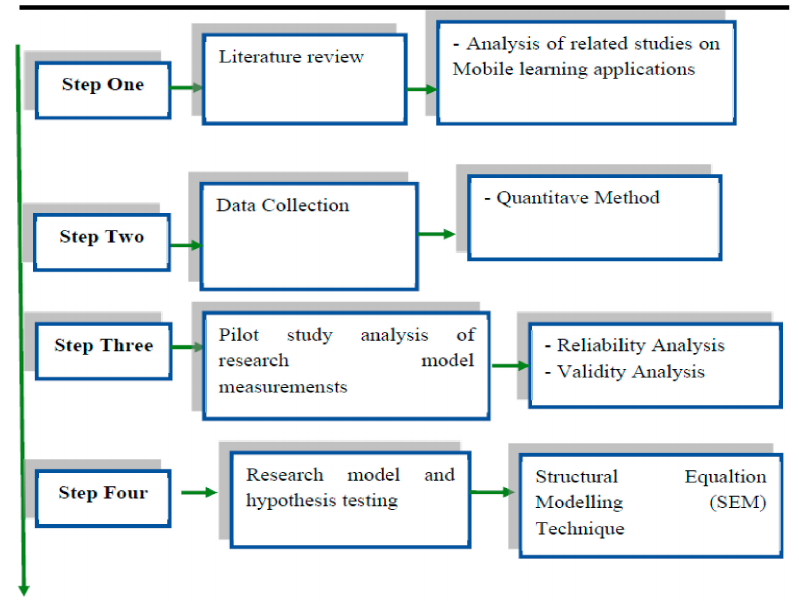
Figure 2. Research